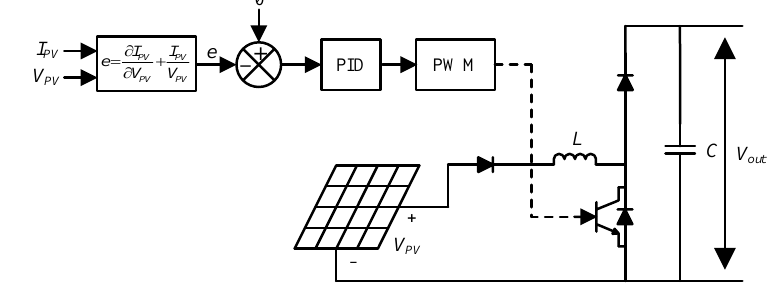
Figure 2. Control of photovoltaic (PV).